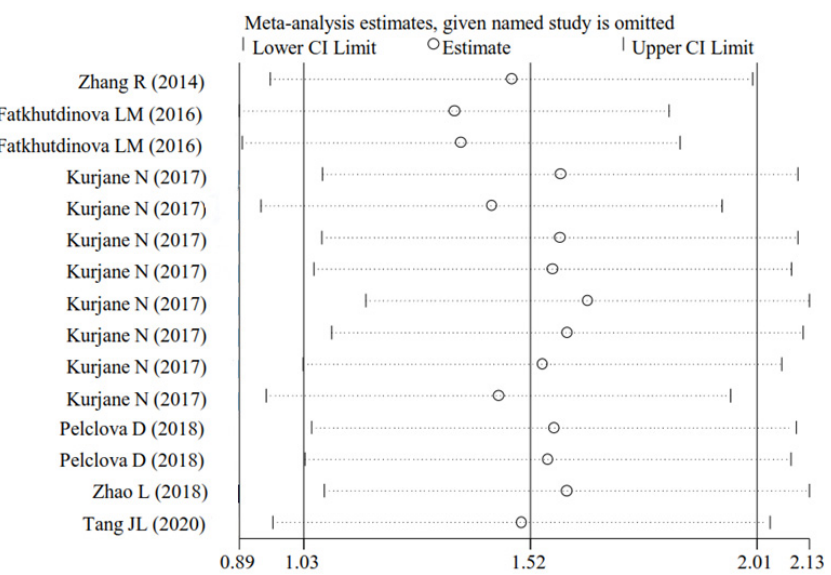
Figure 12. Sensitivity analysis for TNF- α . The vertical axis shows the omitted study. The horizontal axis represents the corresponding pooled estimate when the study is excluded. Every circle indicates the pooled SMD (all of them are close to 1.52 obtained in the overall meta-analysis). The two ends of every broken line represent the respective 95% CI. TNF- α , tumor necrosis factor- α ; SMD, standardized mean difference; CI, confidence interval [17,19,25,36,39,40].